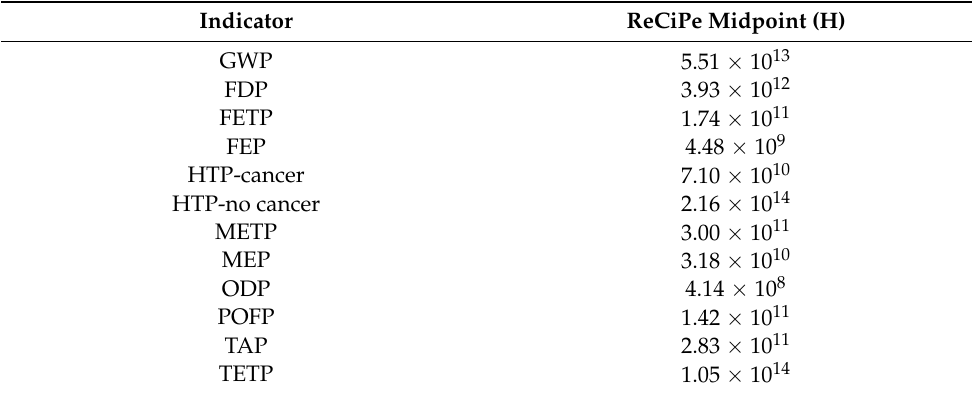
Figure 6. Normalized impacts of different concrete mixes on midpoint damage categories. Table 6. Normalization scores for ReCiPe 2016 methodology [90] .